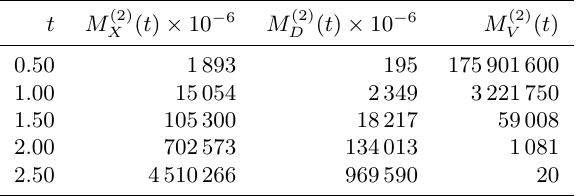
M (2) ( t ) , M (2) ( t ) and M (2) ( t ) as a function of t with C = 3 , N = 412 , n = 98 000 , X D V